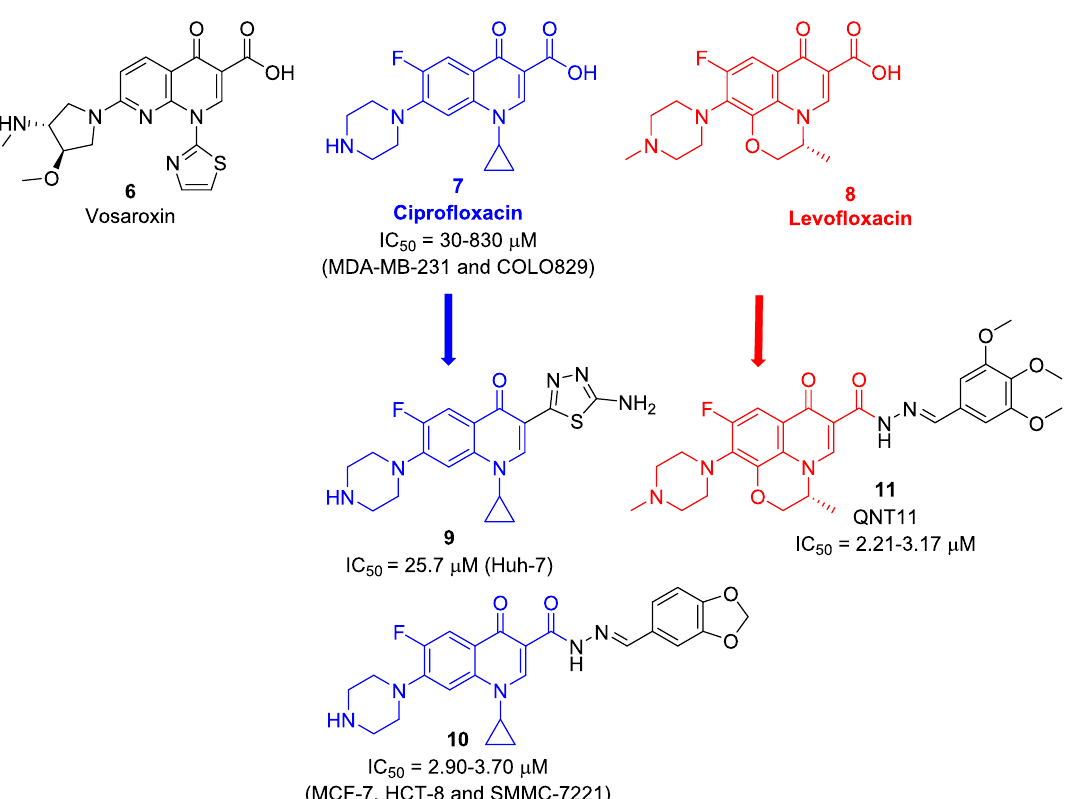
Figure 2. Chemical structures of vosaroxin ( 6 ) and some reported FQ-based Topo II inhibitors ( 9–11 ). Generated using ChemDraw 2021 (https:// perki nelme rinfo rmati cs. com/ produ cts/ resea rch/ chemd raw) 19 .